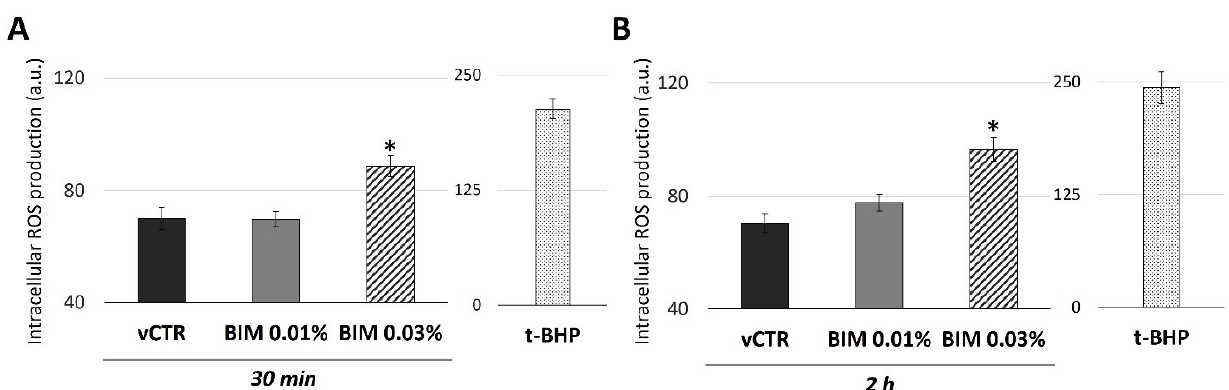
Figure 4. BIM 0.03% induces mild production of intracellular reactive oxygen species (ROS) in HCE cells. ROS production in HCE cells incubated in the absence (vCTR) or the presence of BIM 0.01% and BIM 0.03% for 30 min ( A ) and 2 h ( B ); intracellular ROS production was revealed by fluorimeter, detecting DCFH-DA emission in terms of fluorescence intensity (arbitrary units, a.u.). Cells treated with 200 µM tert-butyl hydroperoxide (t-BHP) were used as a positive control. Values from three independent experiments are expressed as the media ± SE; one-way ANOVA (Dunnett’s method); * p < 0.05 compared with vCTR.